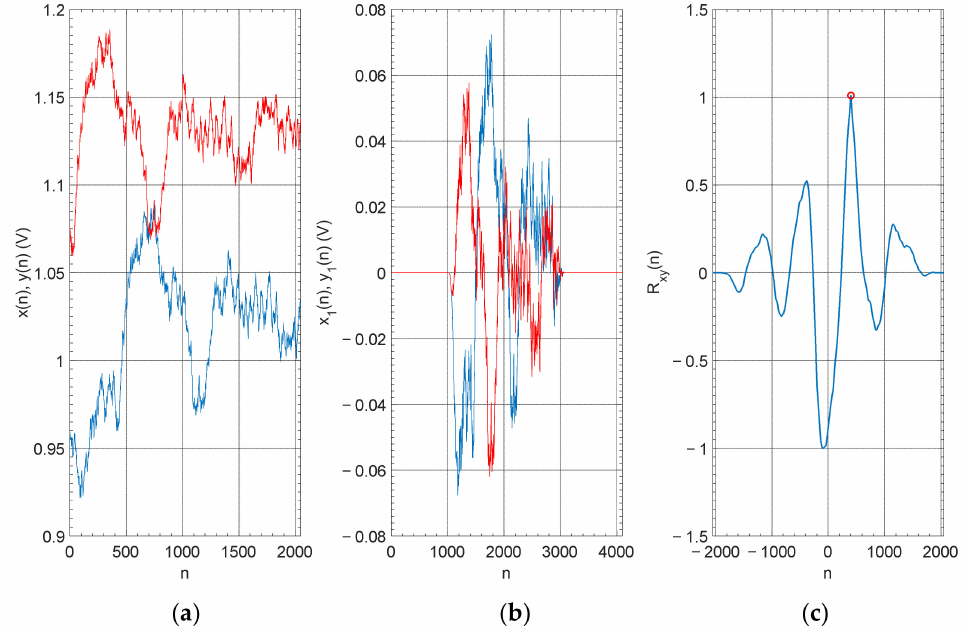
Figure 2. ( a ) The fragments of generated signal, cutting by rectangular window size of 2048 samples. ( b ) The signals prepared to correlation according presented algorithm. ( c ) Correlation matrix with mark correlation